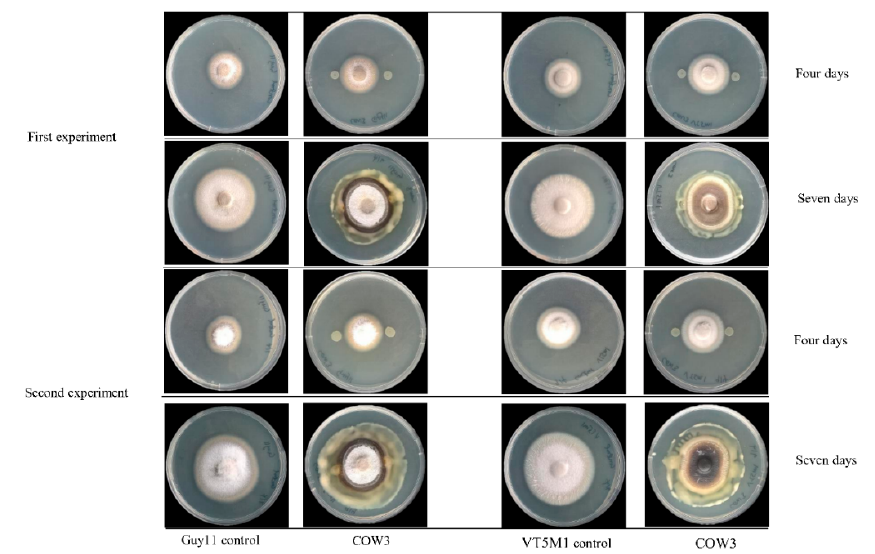
Figure 9. COW3 in vitro antagonistic test against blast fungi. Co-culturing of bananamide D-G-producing strain COW3, with P. oryzae VT5M1 and P. oryzae Guy11. Representative pictures were taken 4 and 7 days, respectively, after the pathogen was added to the center of the Petri dish. The experiment was carried out with 6 repetitions and was repeated in time.